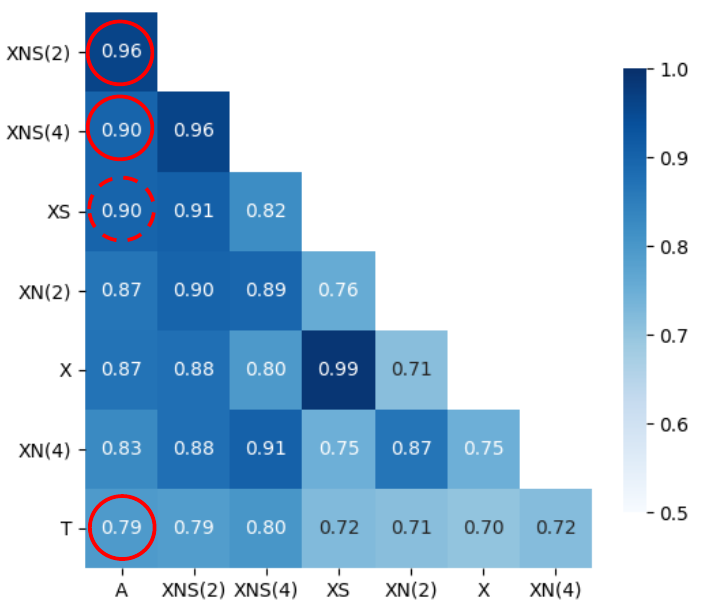
Figure 4. Correlation matrix for model regressors. Solid circles indicate Pearson’s correlation coefficients for multivariate models, and the dashed circle shows the same metric for a univariate model. Notations: A, active cases; X, SARS-CoV-2 load; N, normalised signal; S, smoothed signal; T, number of tests taken; and (number), a signal with number time step delay.